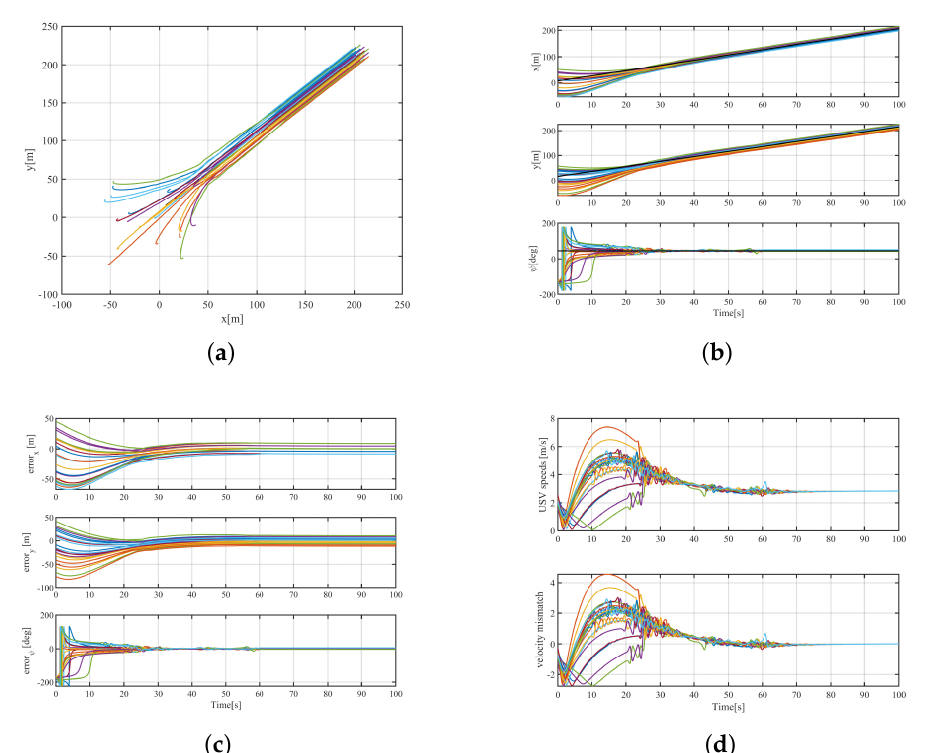
Figure 12. The simulation results by using proposed method in [36]. ( a ) Trajectories. ( b ) Positions and headings. ( c ) Tracking errors. ( d ) USV speeds and velocity mismatch.